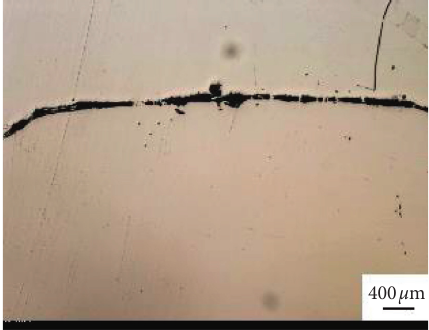
Figure 7: The void was